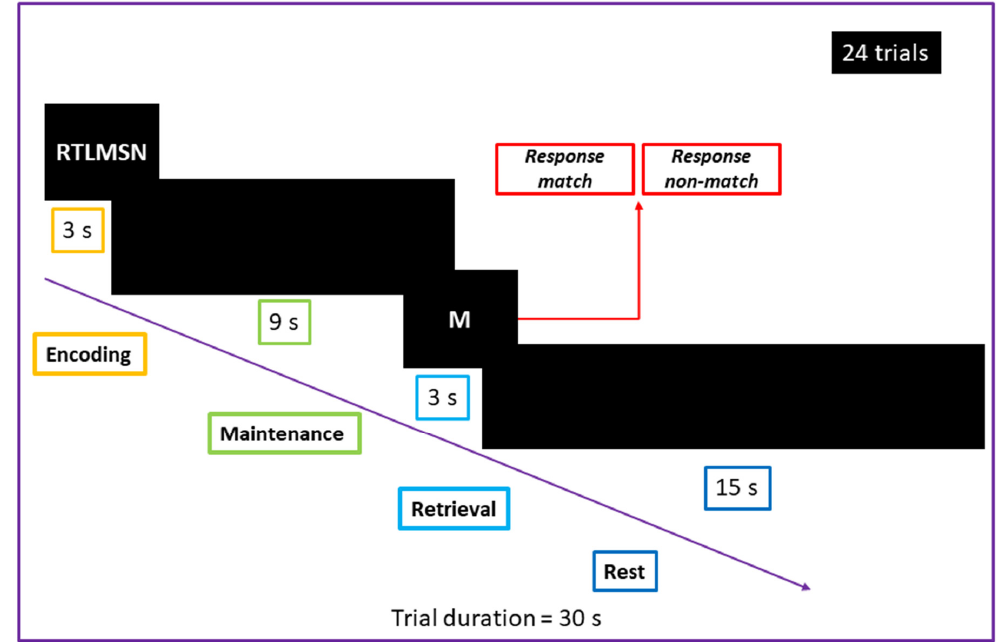
Figure 1. fMRI paradigm with the modified Sternberg task used for individualized determination of stimulation target.